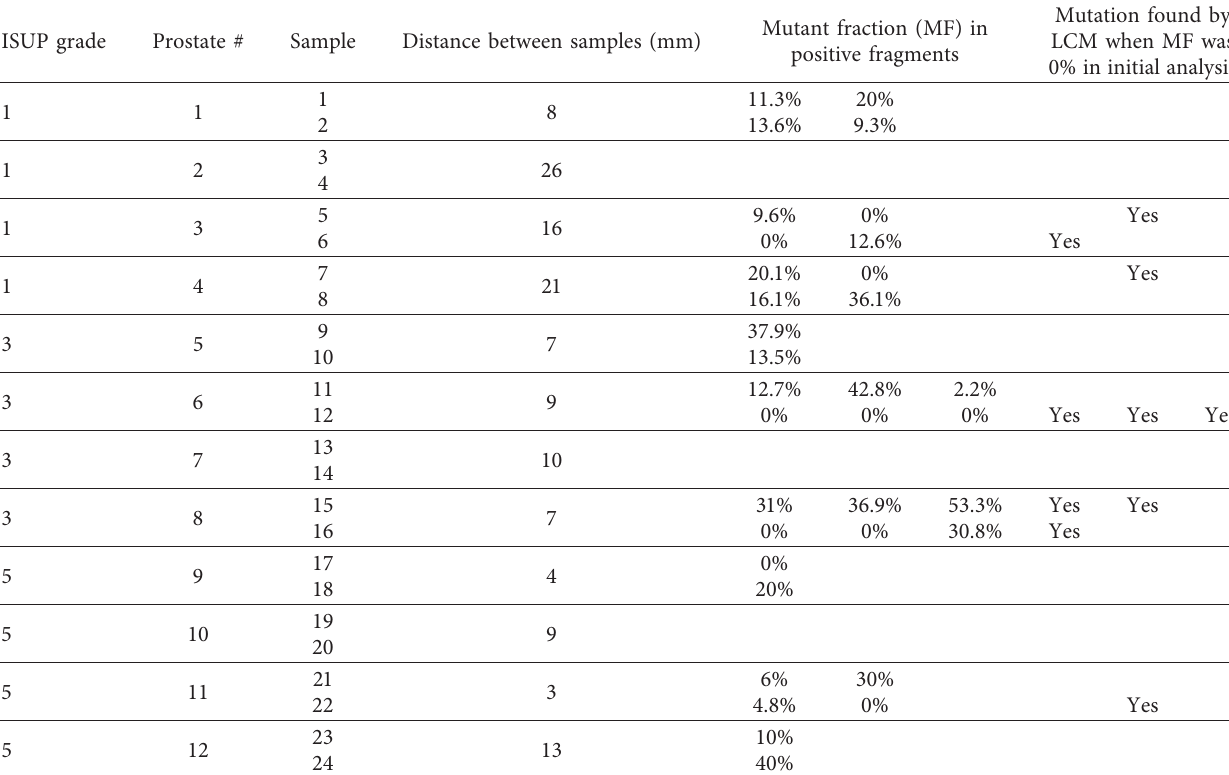
Table 1: Prognostic grade groups (ISUP 1–5), consecutive prostate specimen, and the related sample number. ISUP grade